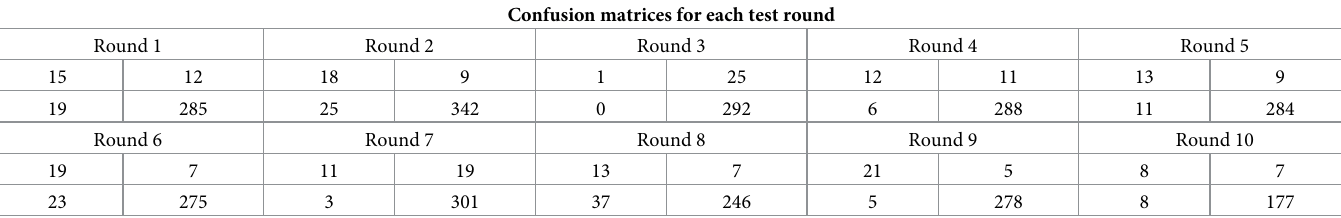
Table 2. Confusion matrices for each test round, where the first row shows the true positive and false negatives values respectively. And the second row shows the false negative and true negative respectively.